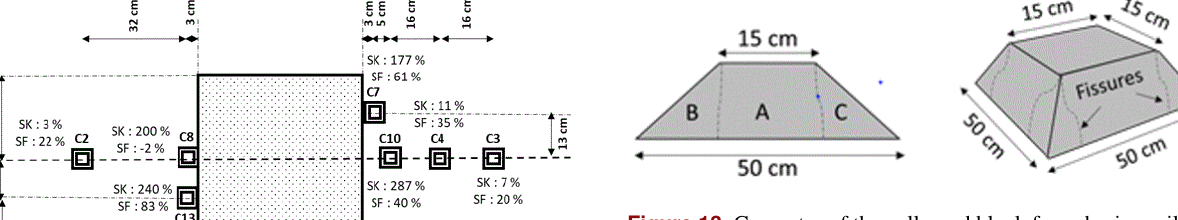
Figure 13. Geometry of the collapsed block for cohesive soil.